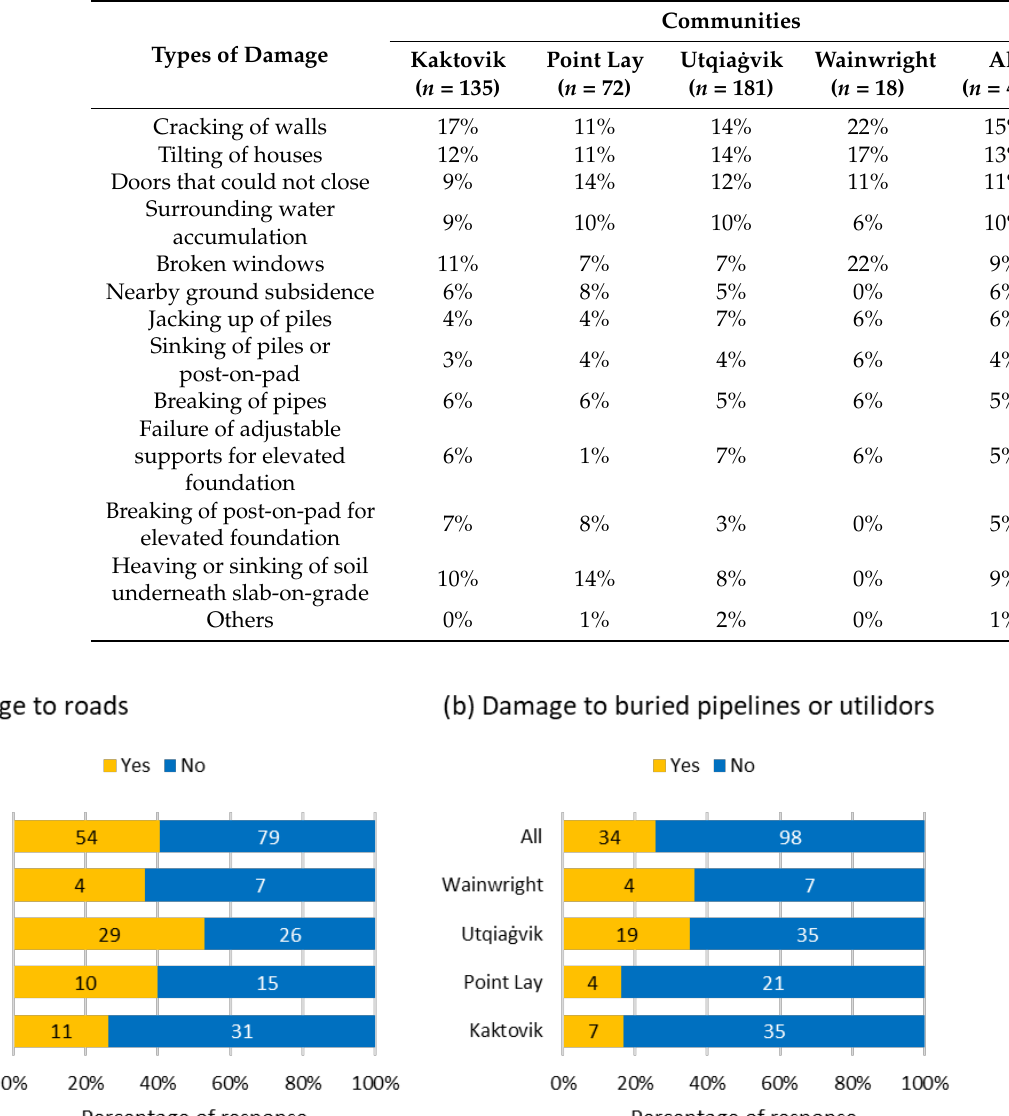
Table 5. Types of damage to residential buildings reported by survey respondents. n is the sample size.